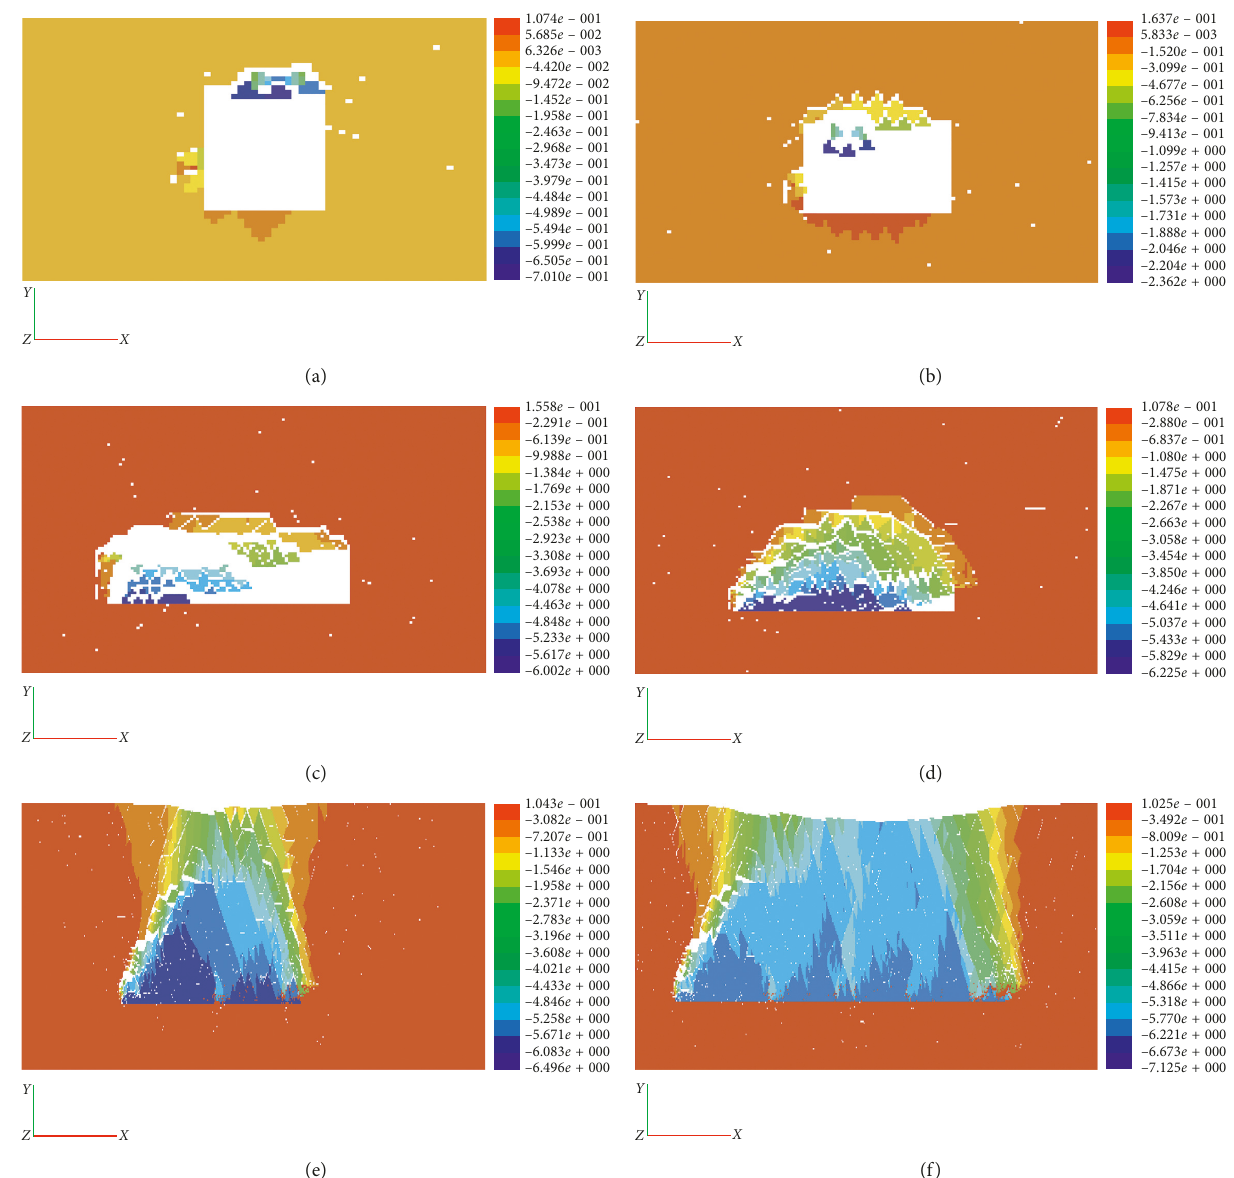
Figure 7: The fracture characteristics and horizontal displacement variation of overlying strata during the working face mining. (a) Mining to 4 m, (b) mining to 8m, (c) mining to 20 m, (d) mining to 40m, (e) mining to 100m, and (f) mining to